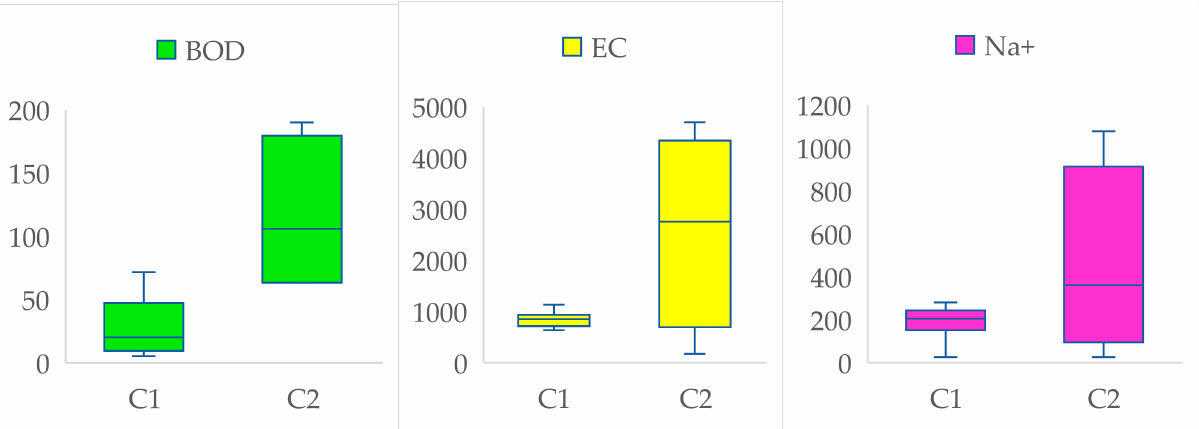
Figure 3. Box plot of the most discriminating parameters, BOD (mg/L), EC ( μ S/cm) and Na + (mg/L) and Wilks’ lambda showing skewedness of discriminatory distribution toward high concentration.